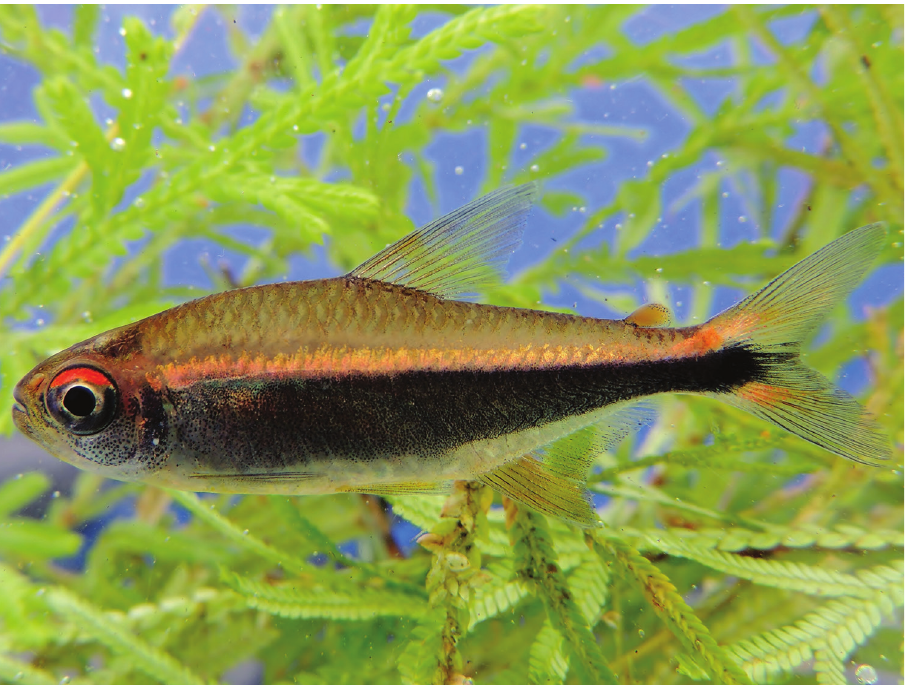
Figure 3. Live colours of Hyphessobrycon klausanni sp. n. Paratype, UARC–IC 540, 22.4 mm